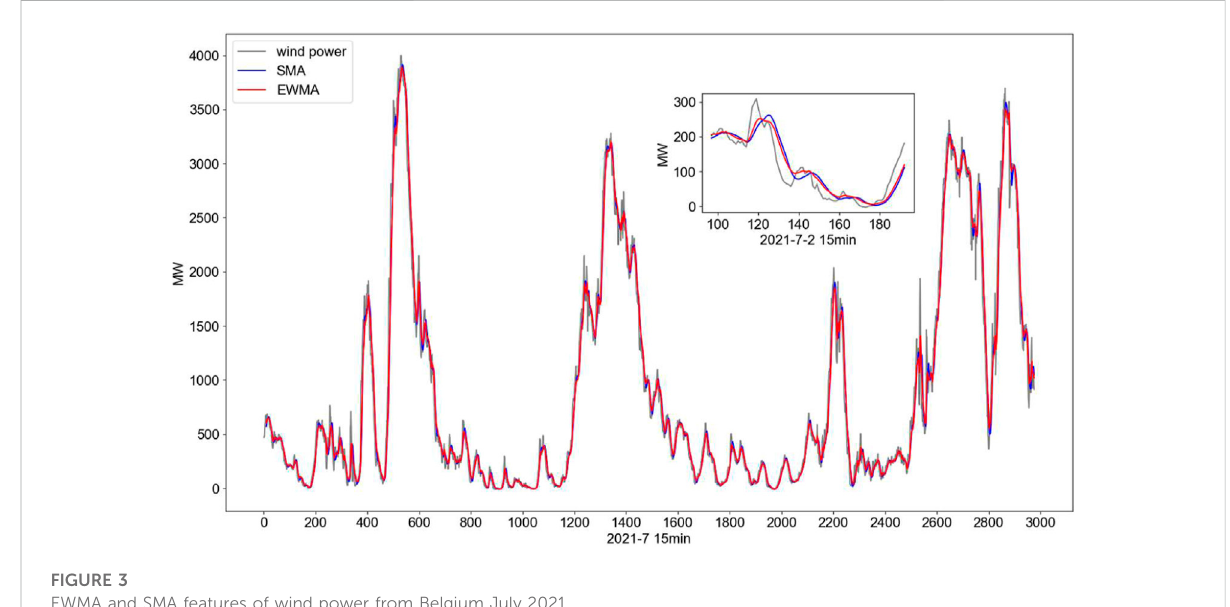
FIGURE 3 EWMA and SMA features of wind power from Belgium July 2021.